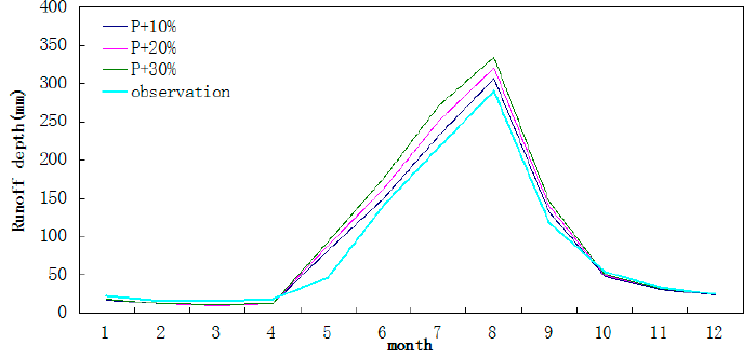
Figure 12. Sensitivity of runoff under various temperature variations relative to the period 2007–2011. Table 5. Change of runoff under various changes of temperature.